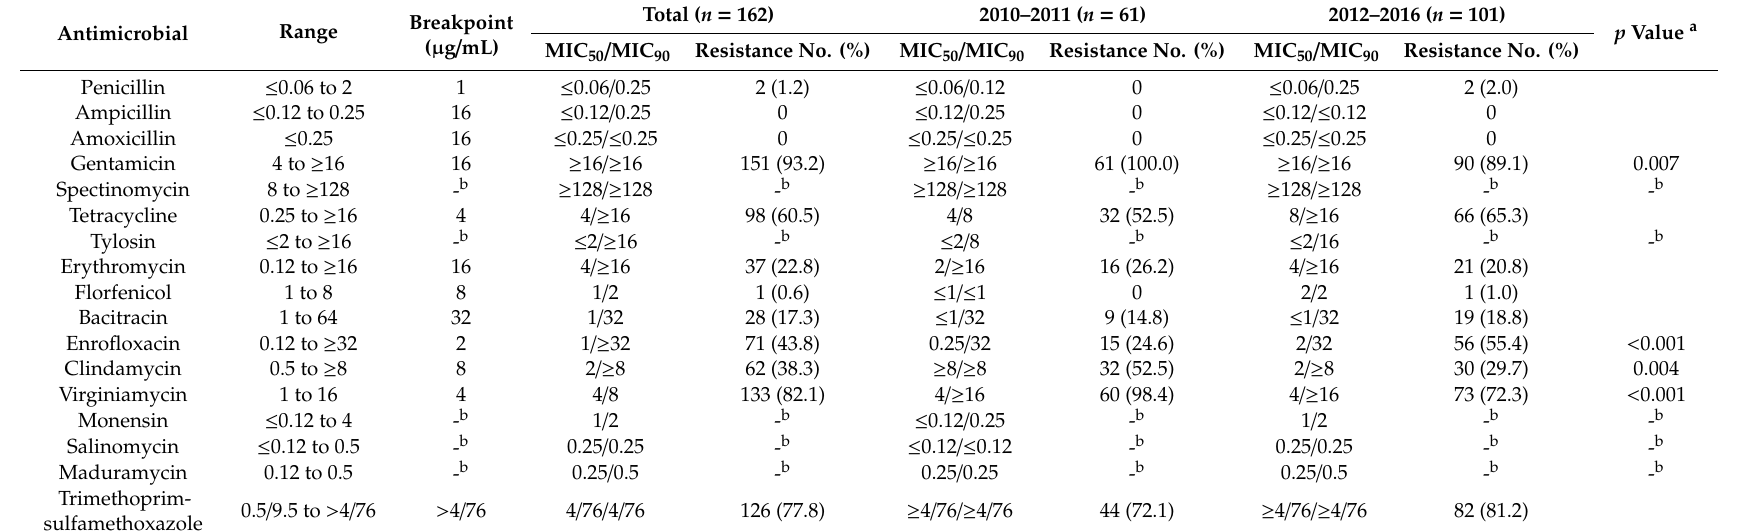
Table 1. Minimal inhibitory concentrations (MICs) against Clostridium perfringens isolates from chickens from 2010 to 2016.